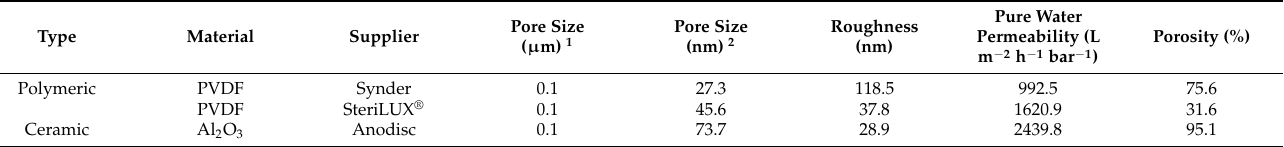
Table 1. Specifications of polymeric and ceramic membranes for the filtration